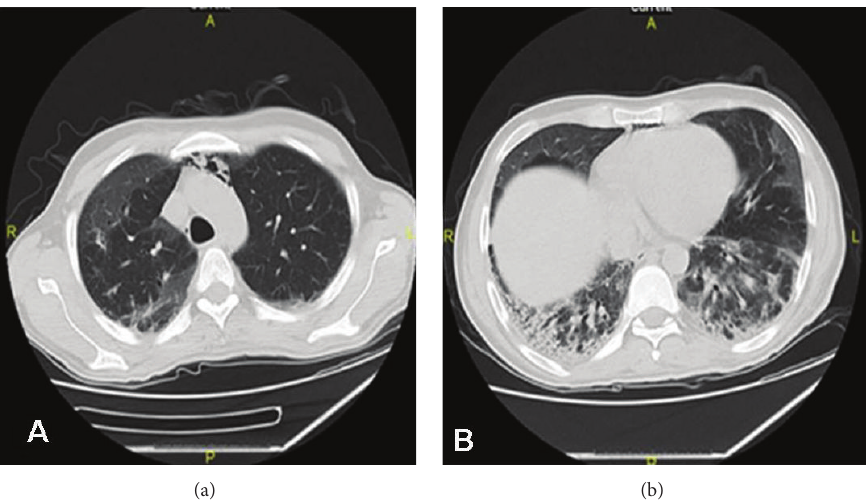
Figure 1: Thorax CT revealing bilateral ground glass opacity in subpleural areas, consolidation, and pneumomediastinum.